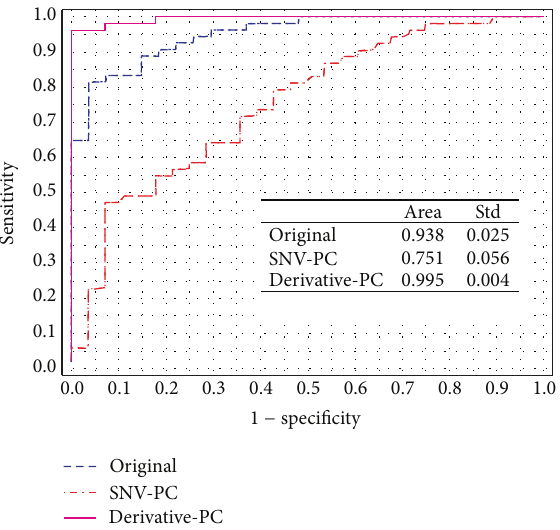
Figure 5: Receiver operating characteristic curves of different models built on the basis of the training